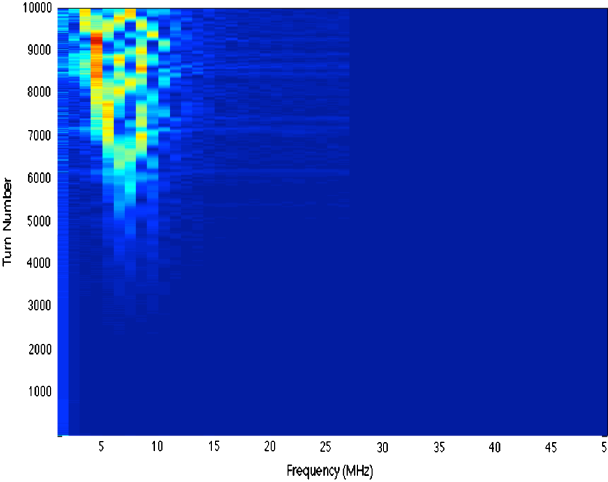
FIG. 9. Evolution of simulated turn-by-turn vertical harmonic spectrum of the extraction kicker